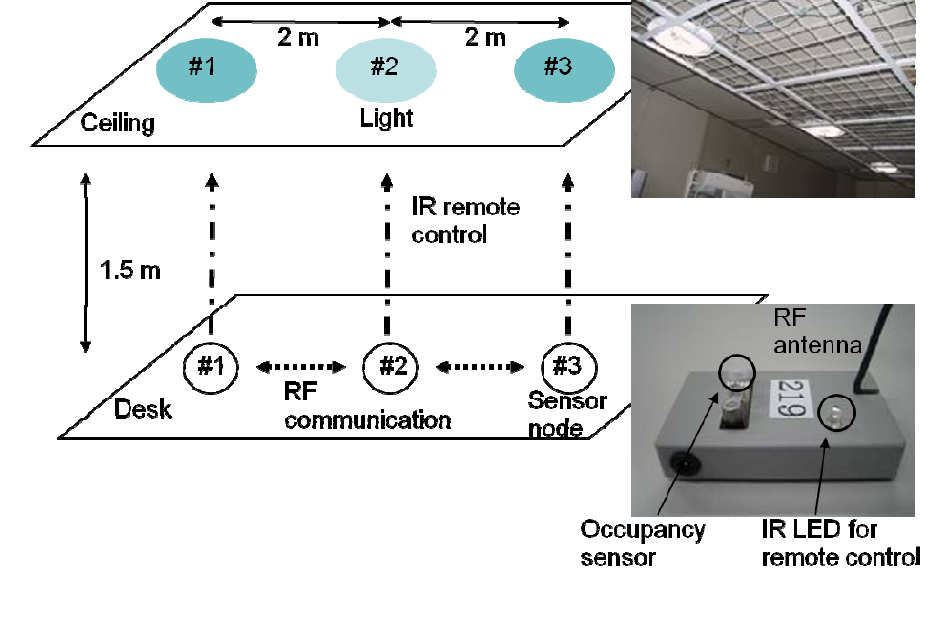
Figure 5. Distributed lighting control experiment using Mote